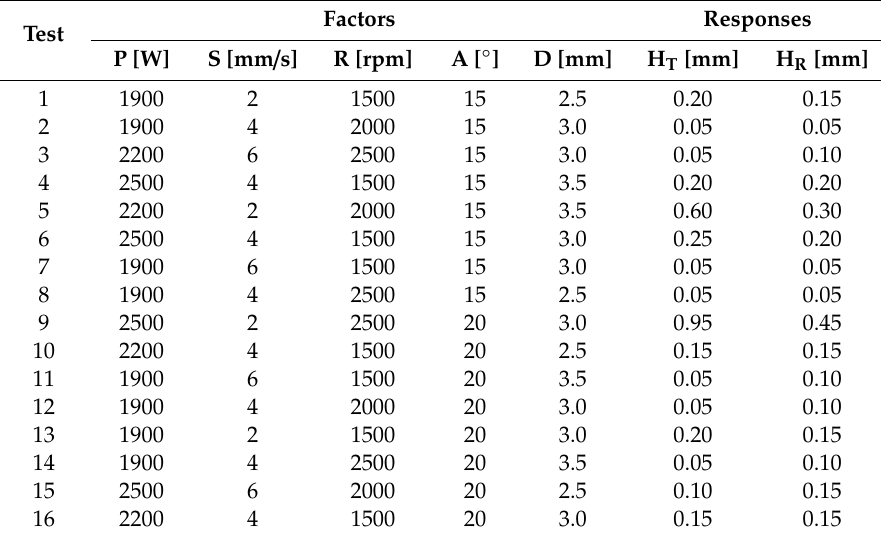
Table 4. Experimental test results with respect to factors variation in each